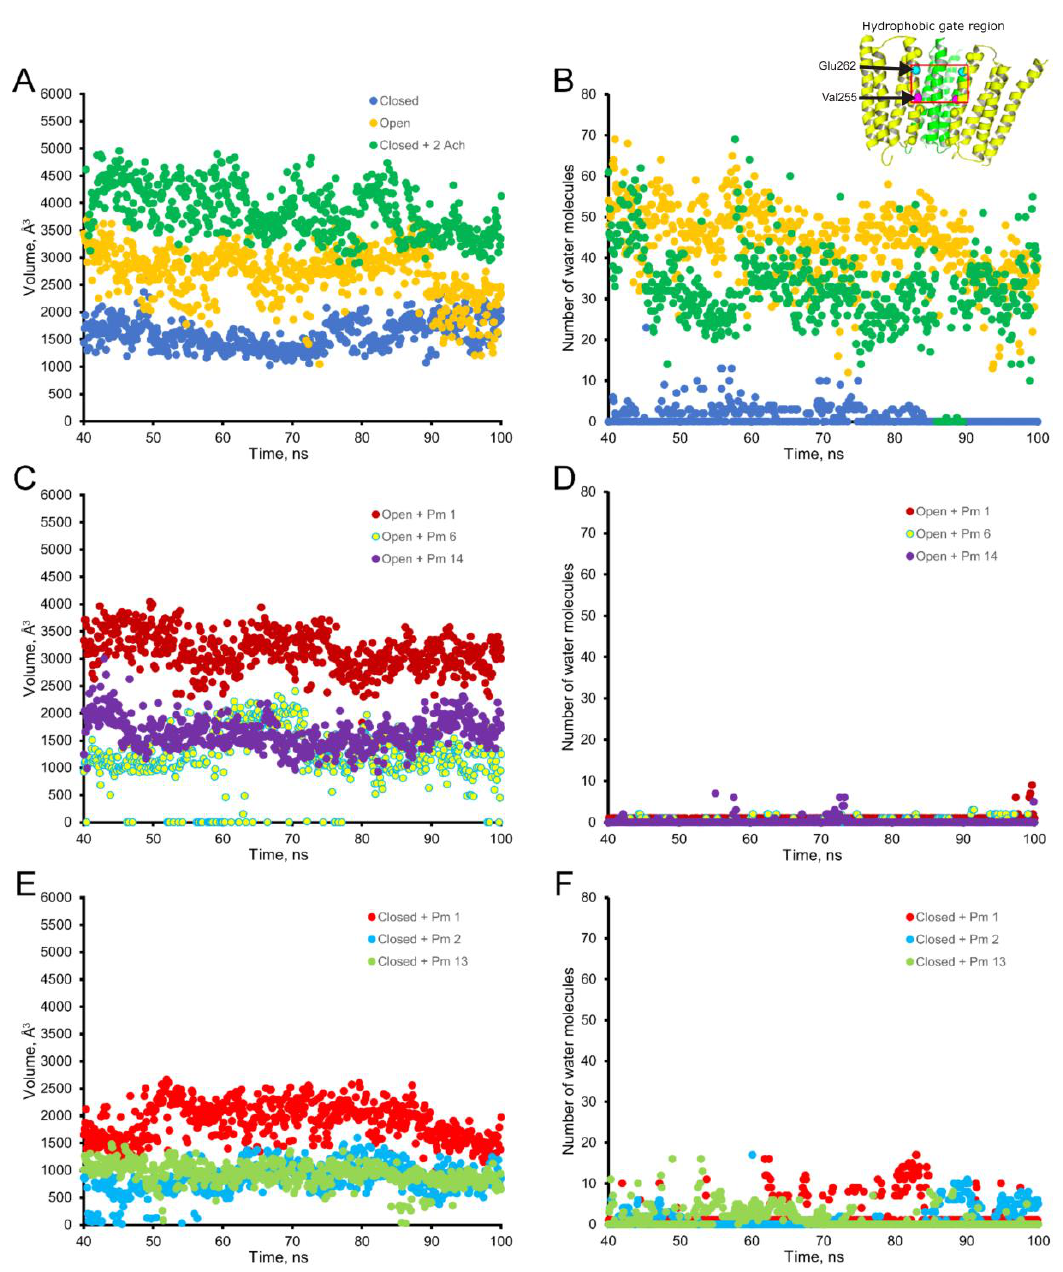
Fig.11 Figure 11. Empty volume (left panels) and number of water molecules (right panels) within the hydrophobic gate of the nAChR pore region (between Val255 and Glu262 of the alpha subunit; see inset in the upper right corner), through the period of 40 to 100 ns of MD simulations. Top panels show the empty volume ( A ) and the number of water molecules ( B ) at the hydrophobic gate region in control nAChR (in the absence of Pm), both in the open (yellow) and the closed (blue) conformations; also, it displays the effect of ACh on the closed conformation (green). Middle panels ( C , D ) display the effect of Pm on these parameters when located at representative sites of the nAChR in the open conformation: within the channel pore (Pm 1), at the TMD (Pm 6), and the ECD (Pm 14). Lower panels ( E , F ) demonstrate the effect of Pm at representative loci of the nAChR in the closed conformation: inside the channel (Pm 1), at TMD (Pm 2), and at ECD (Pm